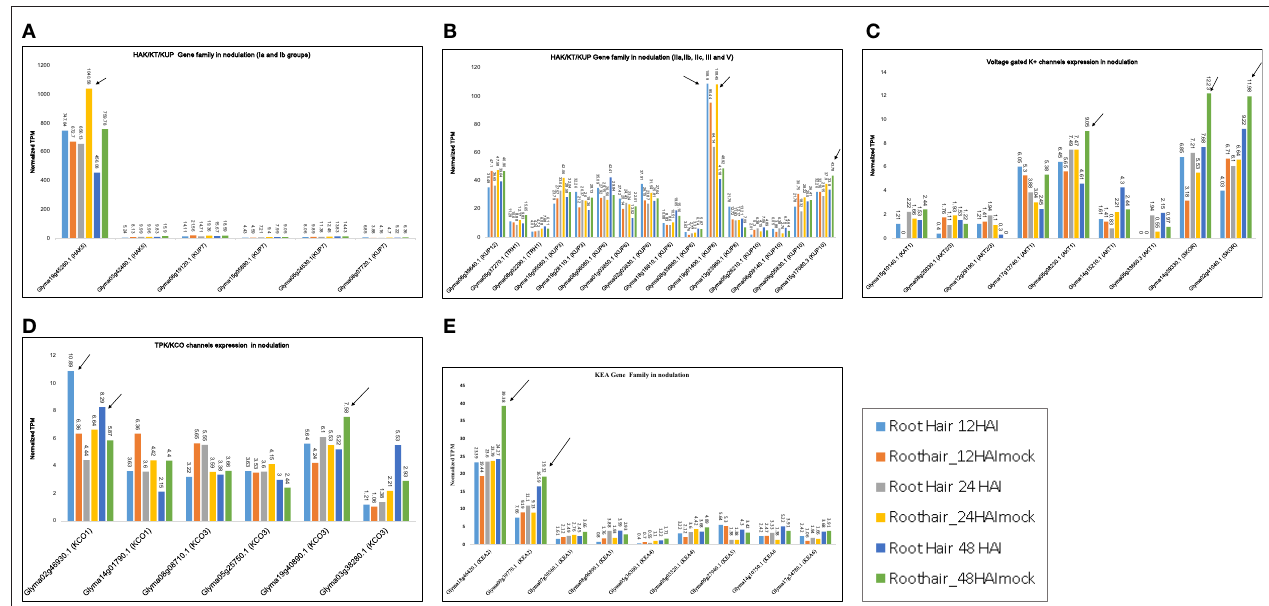
FIGURE 6 | K + transporter gene expression models derived from RNA-seq data for nodulation. Normalized TPM for all genes was recorded based on expression in B. japonicum -treated and mock-treated William 82 root hair samples at 6, 12, 18, 24, and 48 h after inoculation (HAI). Phylogeny-based models represent expression under at least one condition. (A,B) Clades 1a, Ib, IIa, IIb, IIc, III, and V genes from the HAK/KT/KUP family exhibit nodulation-related expression. (C) Expression of voltage-gated K + channel genes in nodulation. (D) Expression of TPK/KCO genes in nodulation. (E) Expression of KEA family genes in nodulation. Arrows are showing the highest expression within a gene